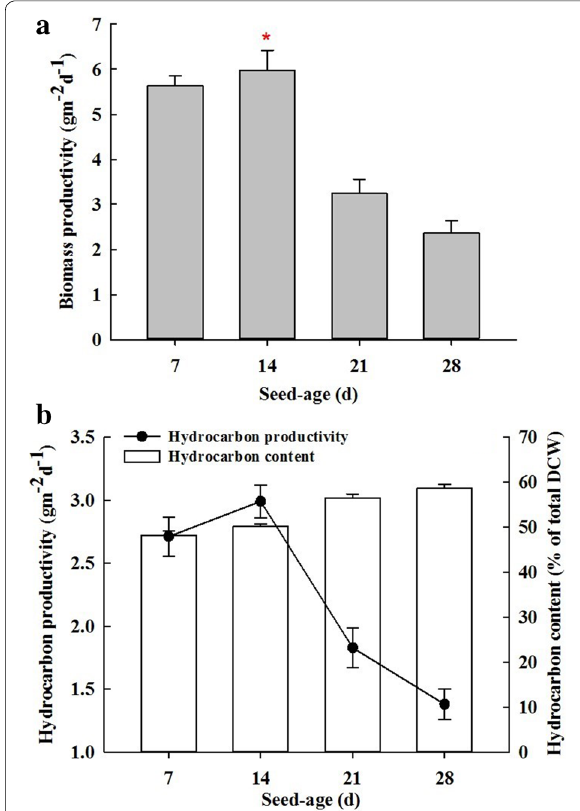
Fig. 1 Effect of seed age on growth and hydrocarbon accumula‑ tion of B. braunii SAG807‑1 under attached cultivation: a Biomass productivity. b Hydrocarbon content and productivity. Data are means standard deviations of three ±